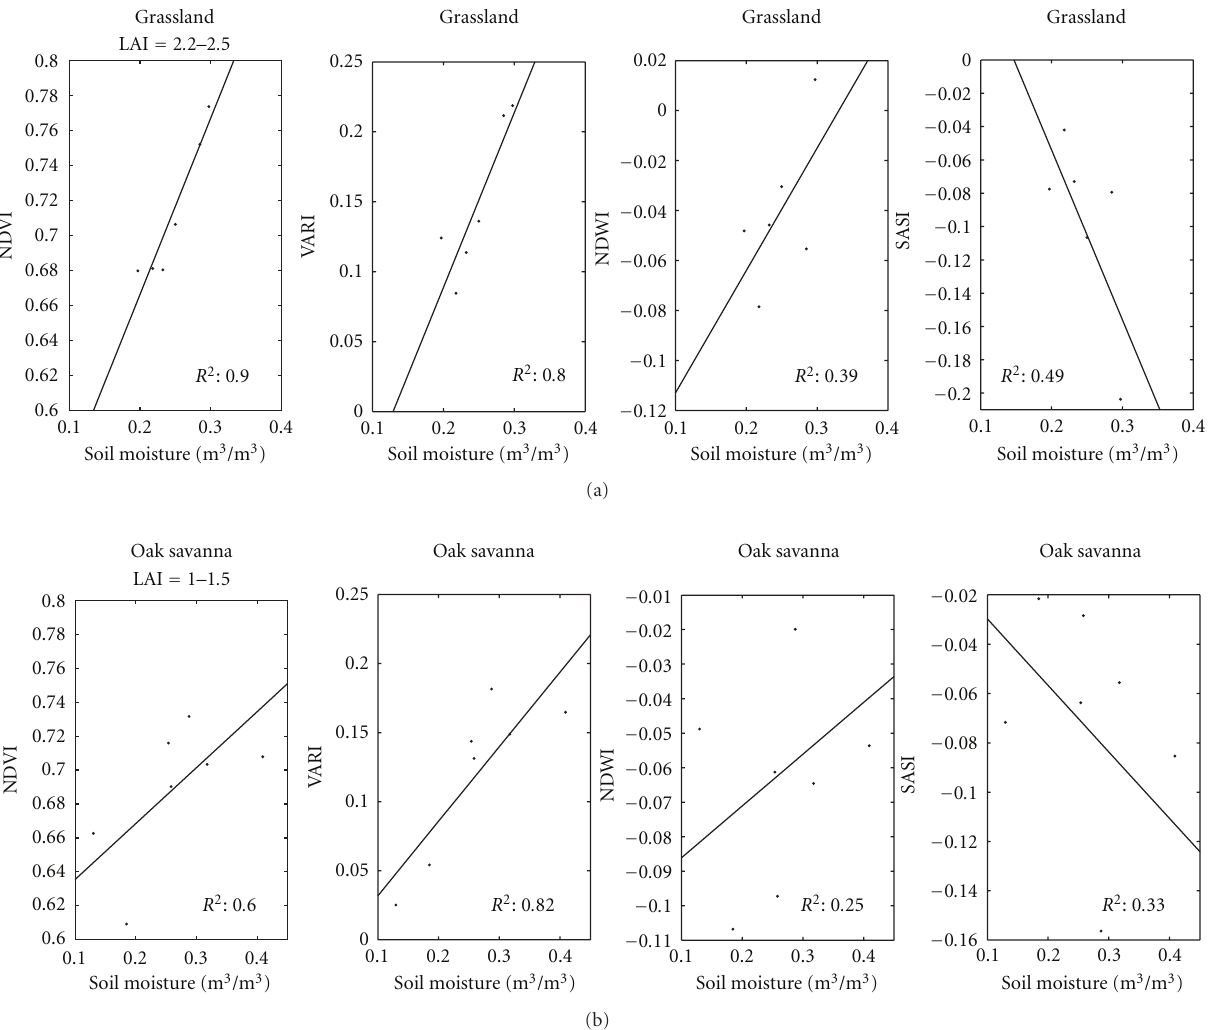
Figure 8: Relationships between vegetation indices and averaged soil moisture at 10 cm in the open grassland (a), and at 20 cm in the oak savanna (b) when LAI reached its maximum at each